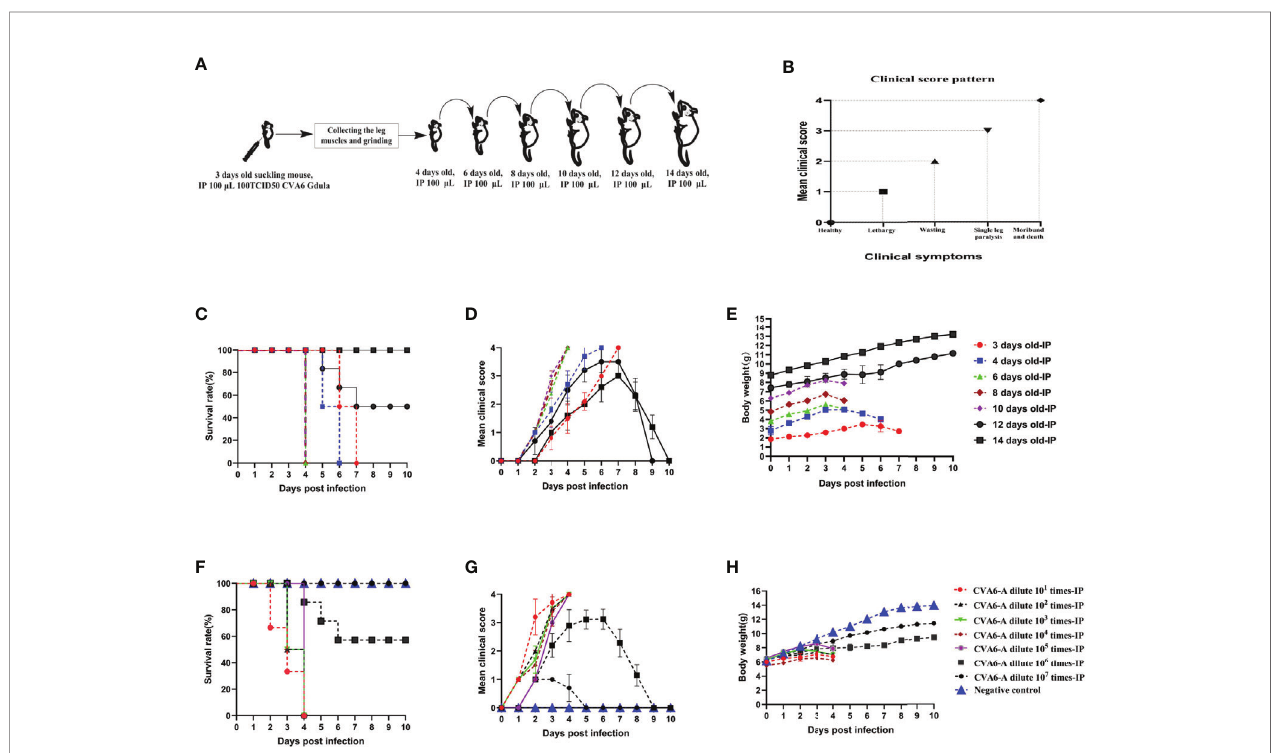
FIGURE 1 | Obtaining the coxsackievirus A6 (CVA6) adapted strain and establishment of the older suckling mice model. The adaptation diagram of CVA6 infecting suckling mice of different ages (A) according to the clinical symptom score standard (B) . For each group of mice (n = 10), the survival rates (C) , clinical scores (D) , and body weights (E) are the main monitoring indicators in the CVA6 infected suckling mice of different ages, via intraperitoneal injection. The LD50 of CVA6 adapted strain for 10-day-old suckling mice (10 per group, 7 groups) that were intraperitoneally injected with seven concentrations of virus fl uid was calculated to be nearly 105.0 TCID50/mouse. The survival rates (F) , clinical scores (G) , and body weights (H) were identical to the